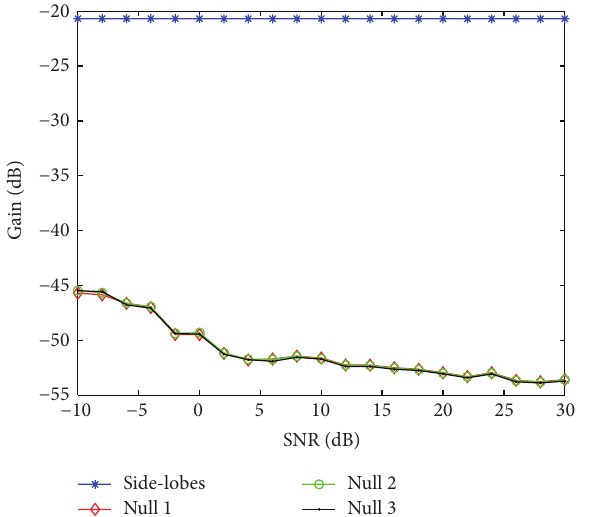
Figure 6: The levels of side-lobe and null depths in interference directions.